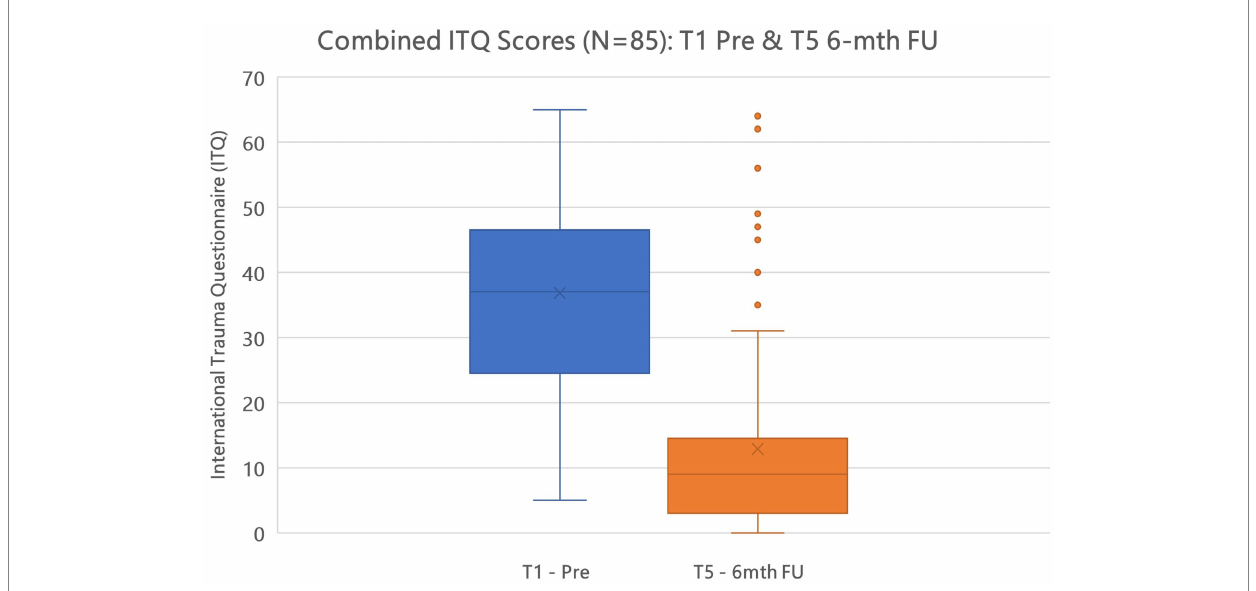
FIGURE 5 Combined ITQ T1 pre and T5 6-mth FU scores active and control (delayed) groups ( N =85) @ p < 0.001.